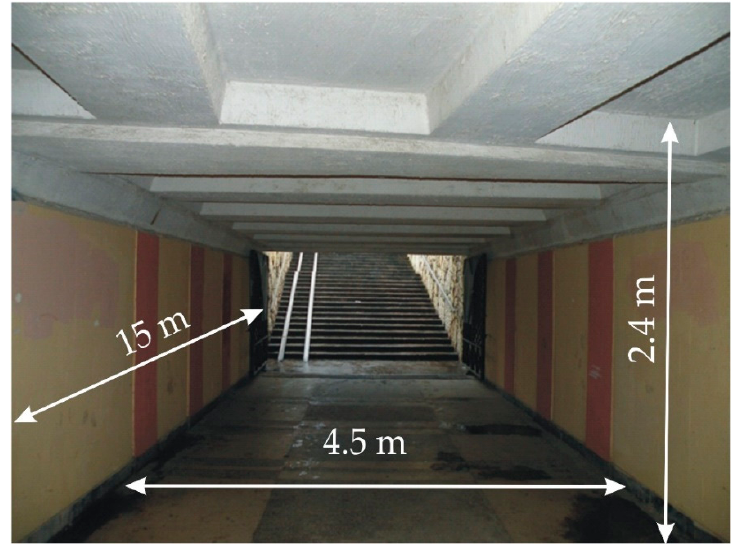
Figure 3. Underground pedestrian crossing.